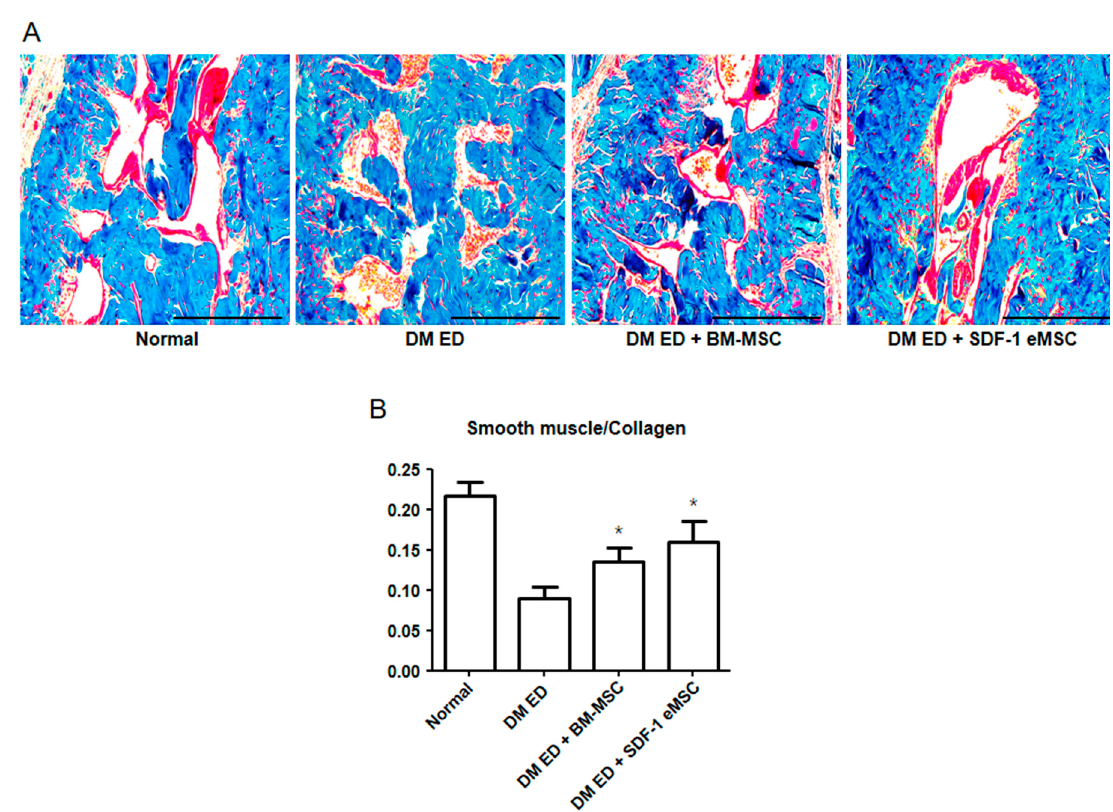
Figure 2. Representative images of Masson Trichrome staining in the corpus cavernosum. ( A ) Red indicates smooth muscle, and blue represents collagen. Scale bar: 100 µ m. Original magnification: × 100; ( B ) Percentage area of smooth muscle for each group. Each bar shows the mean value (standard deviation). * p < 0.05 compared with the DM ED group.